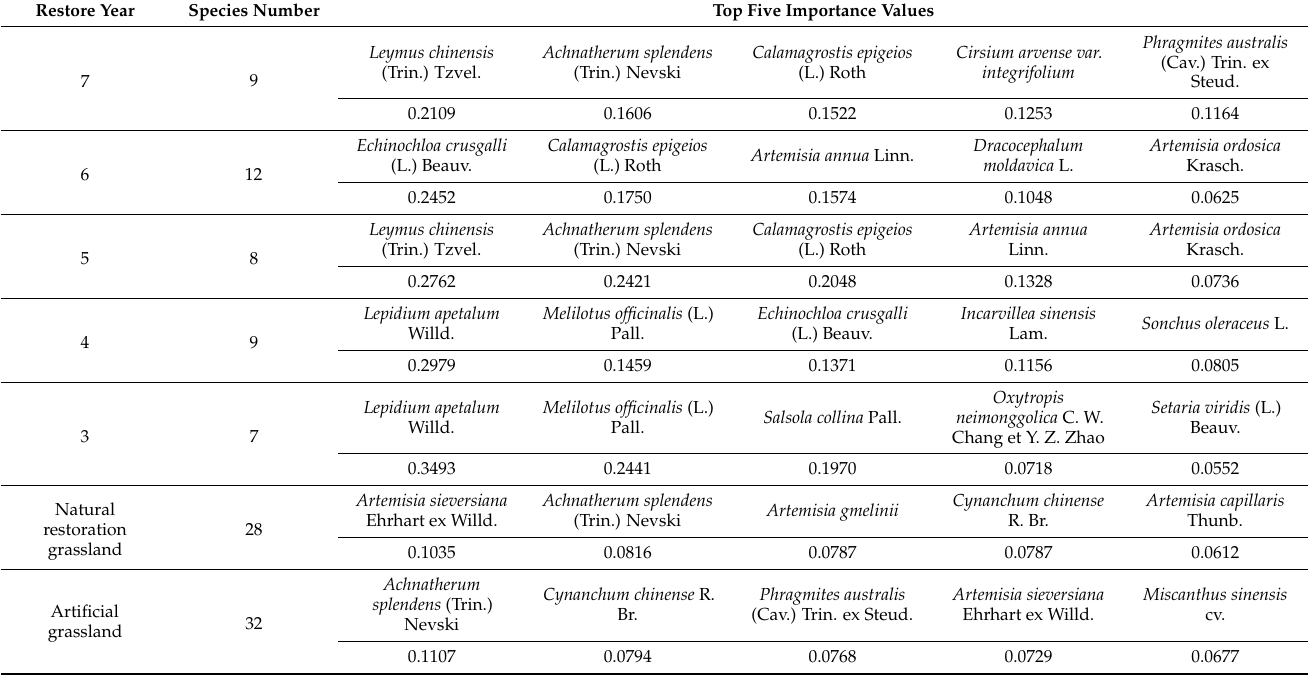
Table 4. General situation of herbaceous plant communities under forests with different restoration